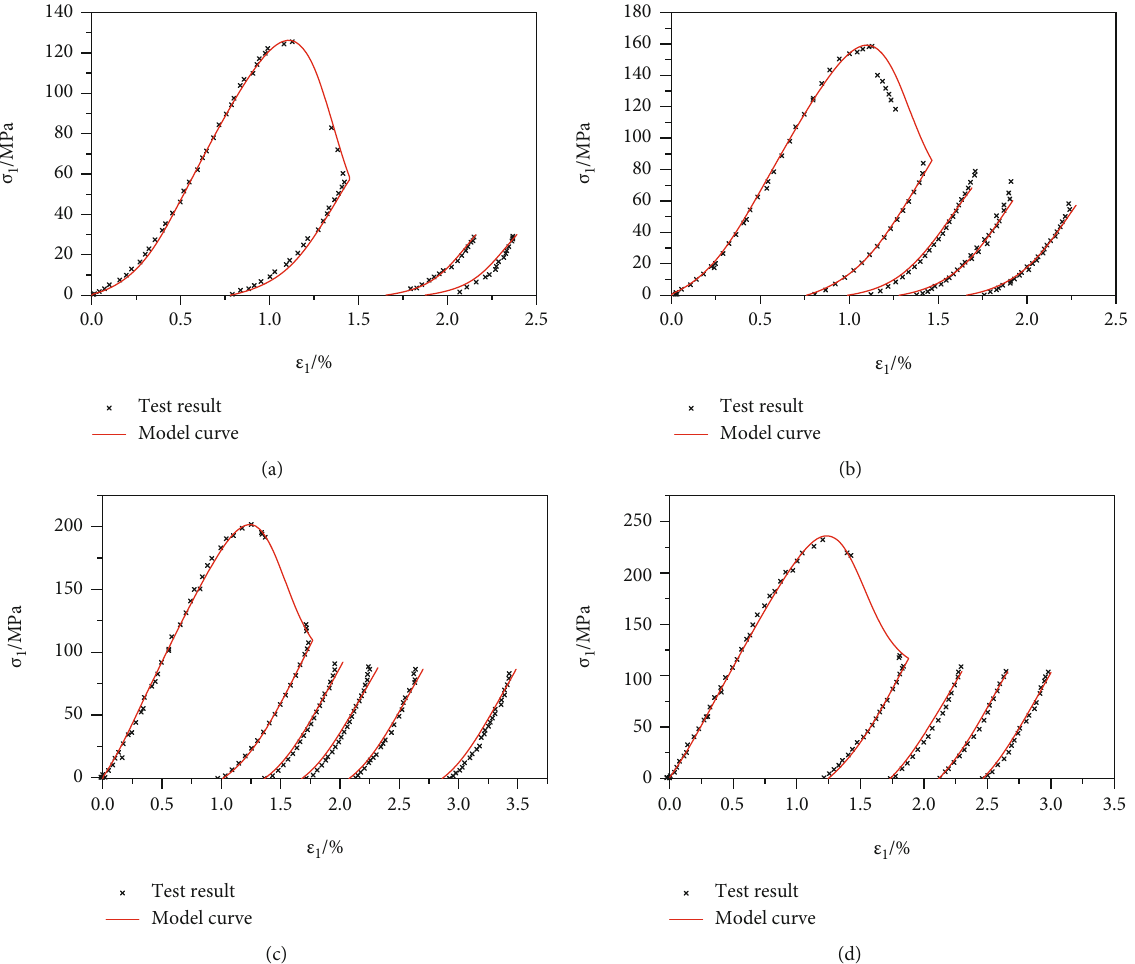
Figure 18: Comparison of test results and model results of postpeak unloading under di ff erent con fi ning pressures ((a) 5MPa, (b) 10 MPa, (c) 20MPa, and (d) 30